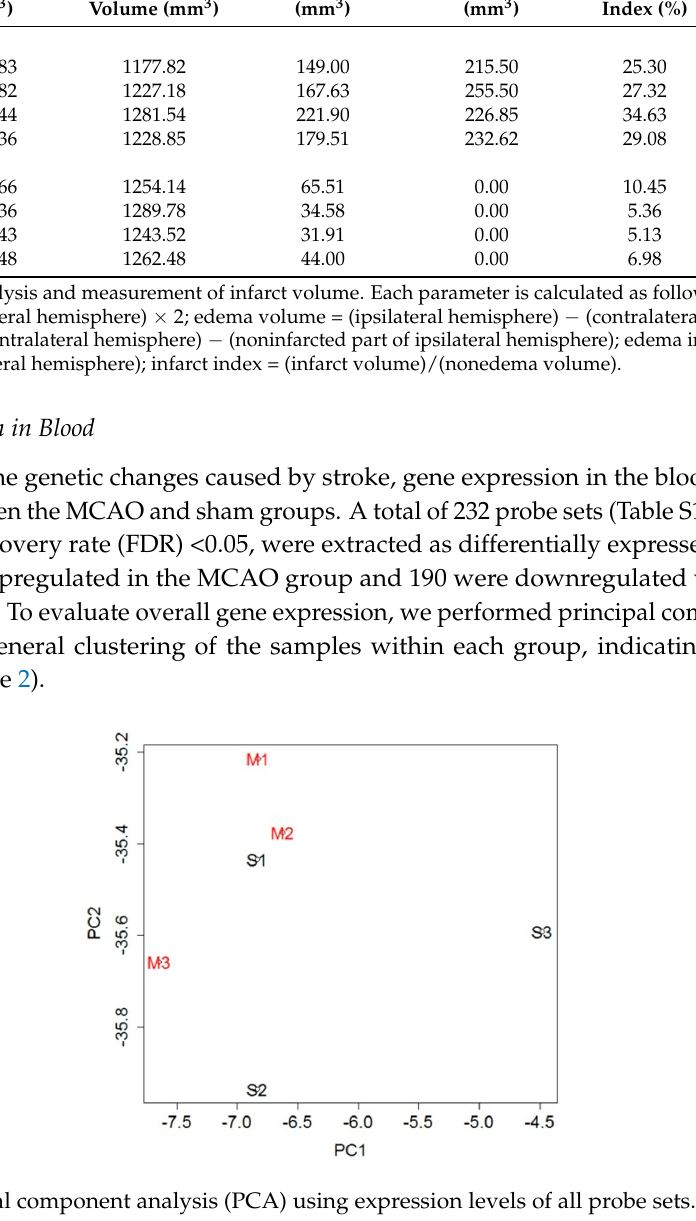
Table 1. Image analysis of middle cerebral artery occlusion (MCAO)- or sham-treated brain slices. Total Volume (mm 3 )